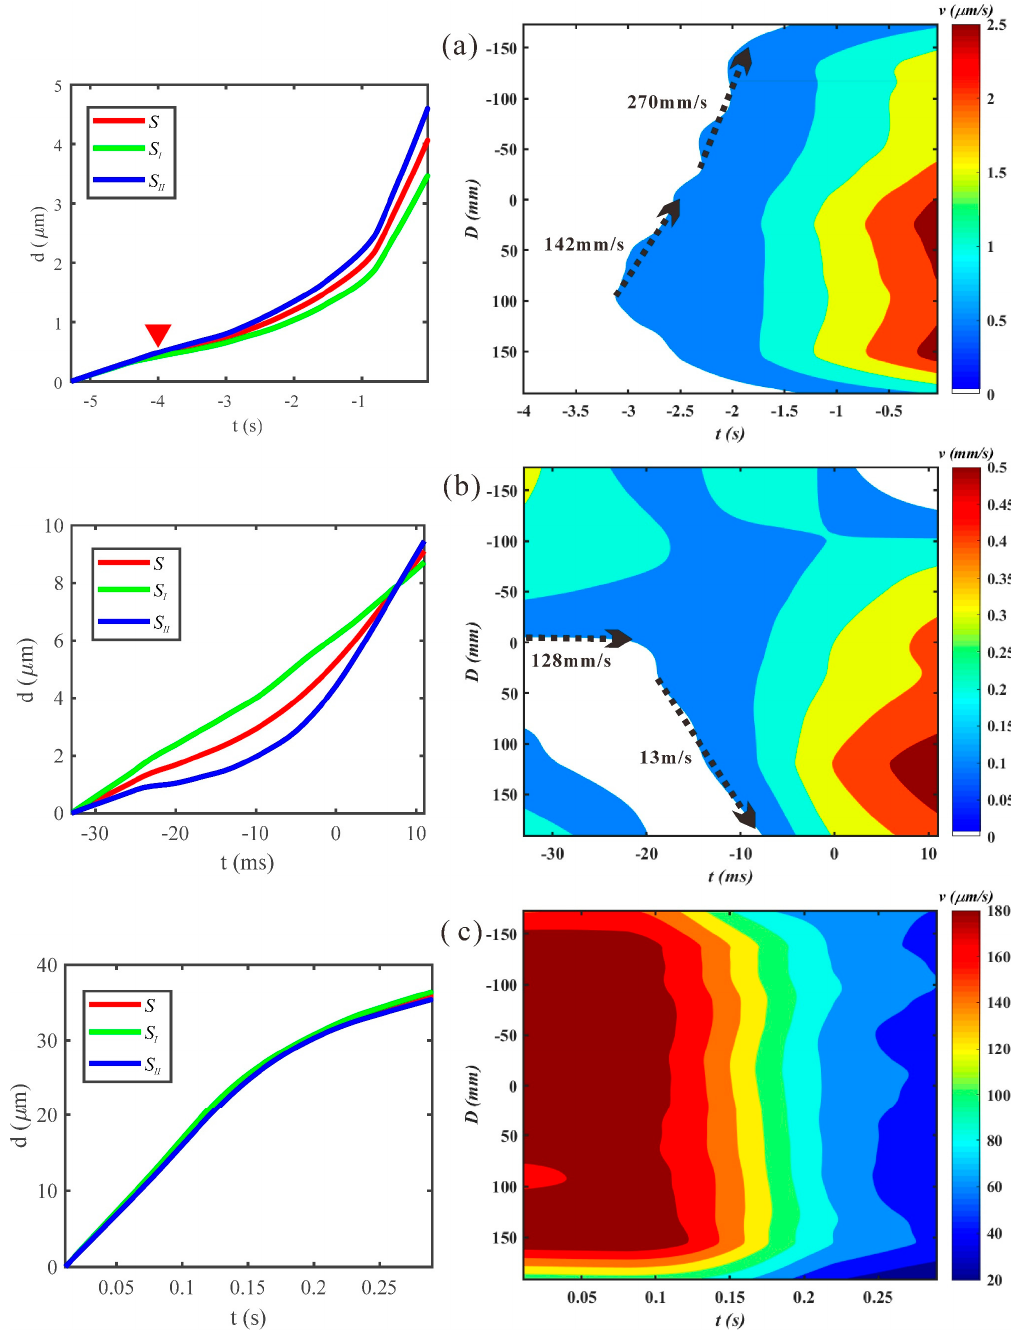
Figure 6. Spatiotemporal distribution of fault slips and slip velocity before and after the overall instability of event E3. The time axes from ( a ) to ( c ) are continuous. Labels are the same as shown in Figure